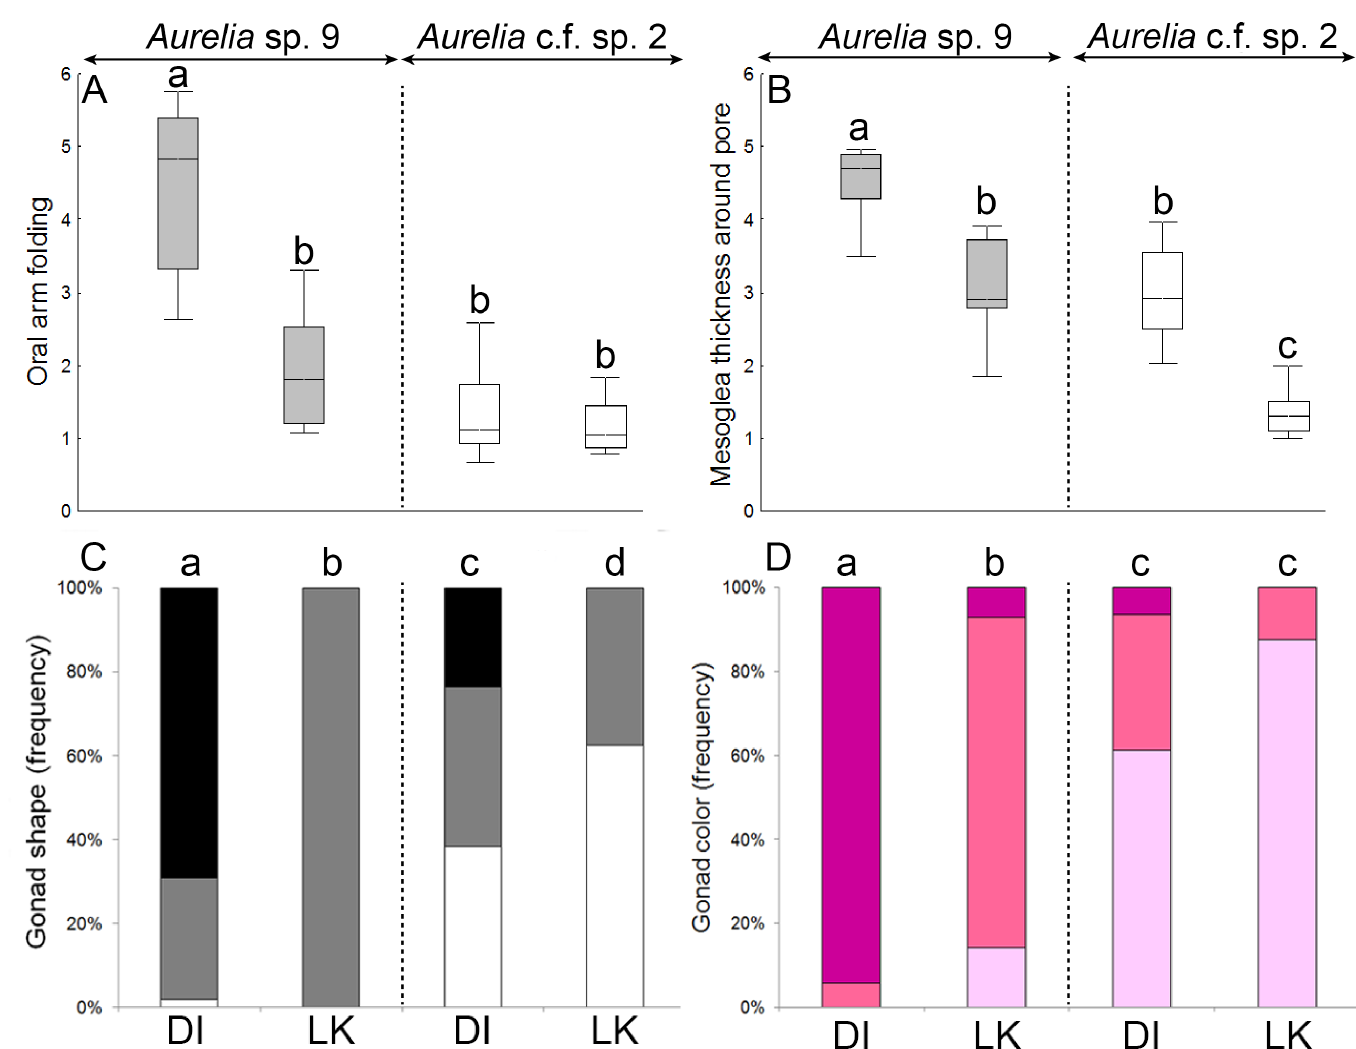
Fig 10. Morphological variation in categorical features of Aurelia medusae in the Gulf of Mexico. A-B: Ordinal categorical features. C-D: nominal categorical features. DI: Dauphin Island (AL), which represents the Central Northern Gulf of Mexico. LK: Long Key (FL), which represents the Southeastern Gulf of Mexico. Features explaining 90% of the total morphological variation (SIMPER) are shown. Different letters above whiskers indicate significant differences among groups detected by post-hoc Kruskal-Wallis tests (P < 0.001; A-B) and Chi-square tests (P < 0.001; C-D). Gonad shape in panel C are: U- shape (hollow bars), horseshoe (gray bars) and drop-like (black bars). Boxes: median, the 25 – 75% quartiles. Whiskers: Non-outlier